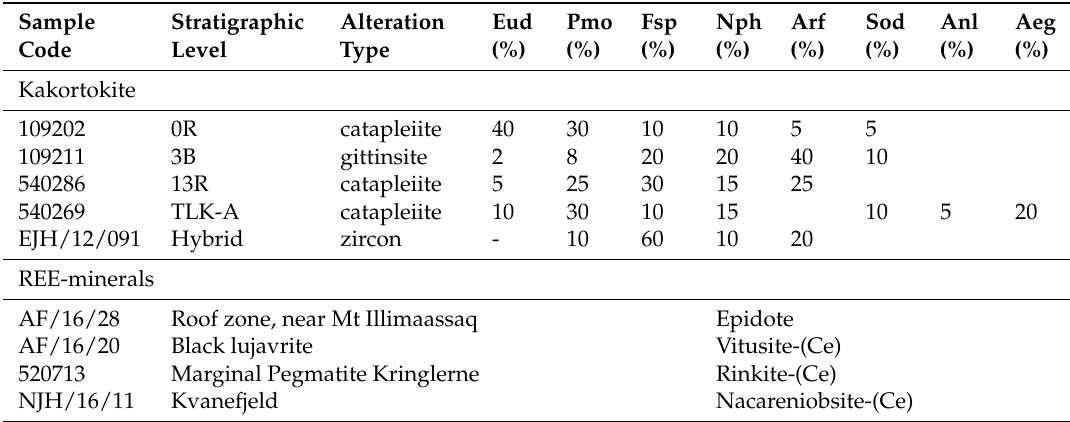
Table 2. Sample overview and major mineralogy of the kakortokite